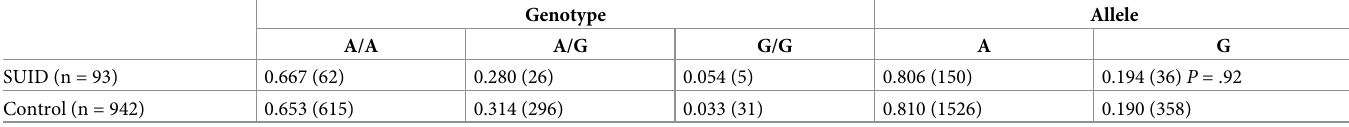
Table 2. Frequency (number) of genotypes and alleles of SNP (rs28647582) in intron 2 in the SUID and control